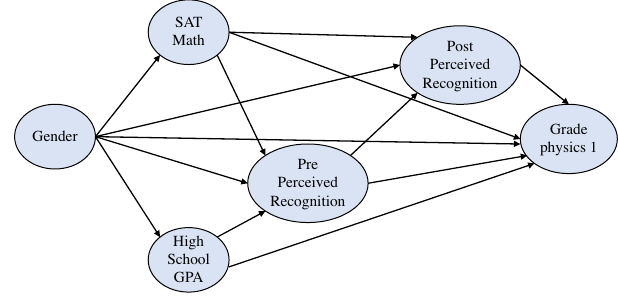
FIG. 1. Schematic representation of the model and how perceived recognition mediates the relation between gender and grade in physics 1 course for bioscience majors. From left to right, all possible paths were considered (including the one from gender to grade in physics 1), however, only some of the paths are shown here for clarity.